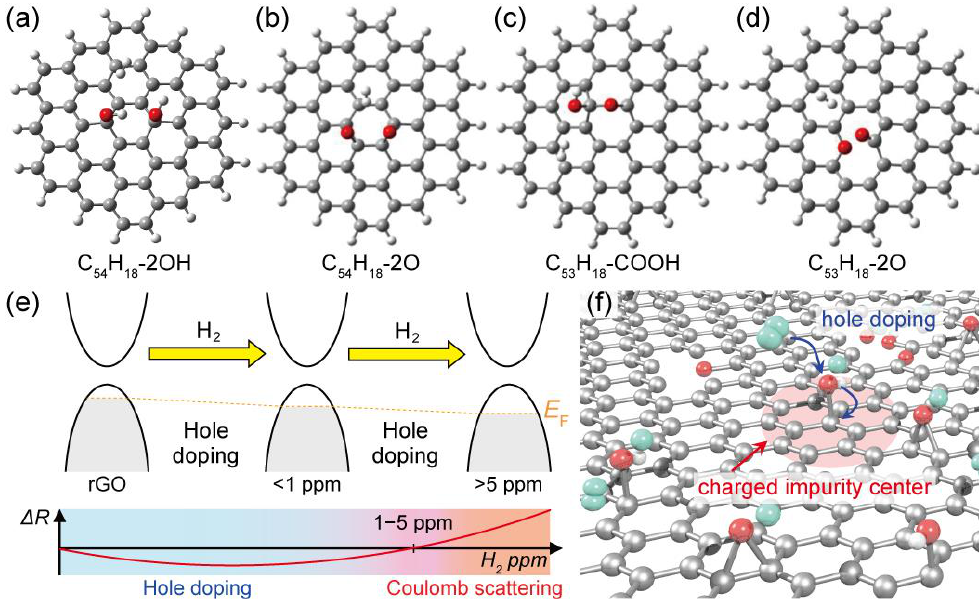
Figure 4. Density functional theory (DFT)-calculated adsorption of molecular hydrogen on graphene oxide and mechanism of resistance change. Graphene oxide with ( a ) two hydroxyl groups, ( b ) two epoxide groups, ( c ) a carboxyl group, and ( d ) ether and ketone groups after adsorption of molecular hydrogen. ( e ) Charge transfer effect and electronic density of states on the nanoporous rGO before and after H 2 adsorption with expected resistance changes. ( f ) Coulomb scattering effect on nanoporous rGO after adsorption. The oxygen-containing functional groups act as charged impurity centers enhanced by hole doping from the adsorbed H 2 .